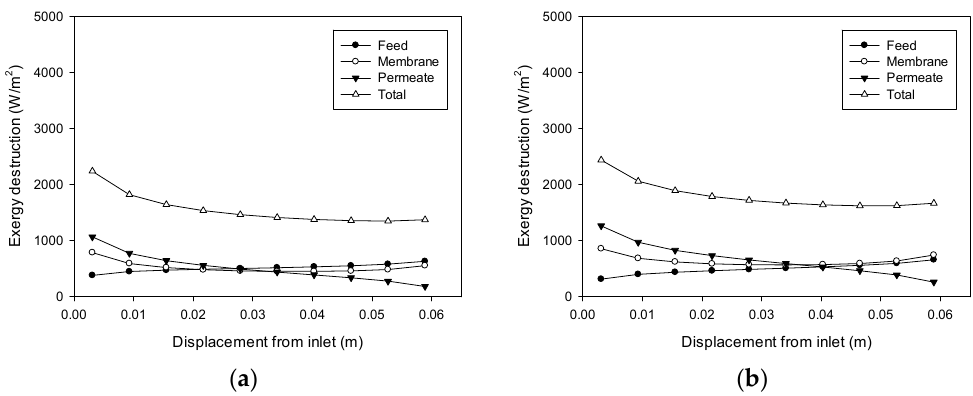
Figure 9. Profiles of exergy destruction in the DCMD module: ( a ) Feed temperature = 60 °C, feed flow rate = 0.24 L/min, and permeate flow rate = 0.4 L/min; ( b ) Feed temperature = 60 °C, feed flow rate = 0.48 L/min, and permeate flow rate = 0.4 L/min.